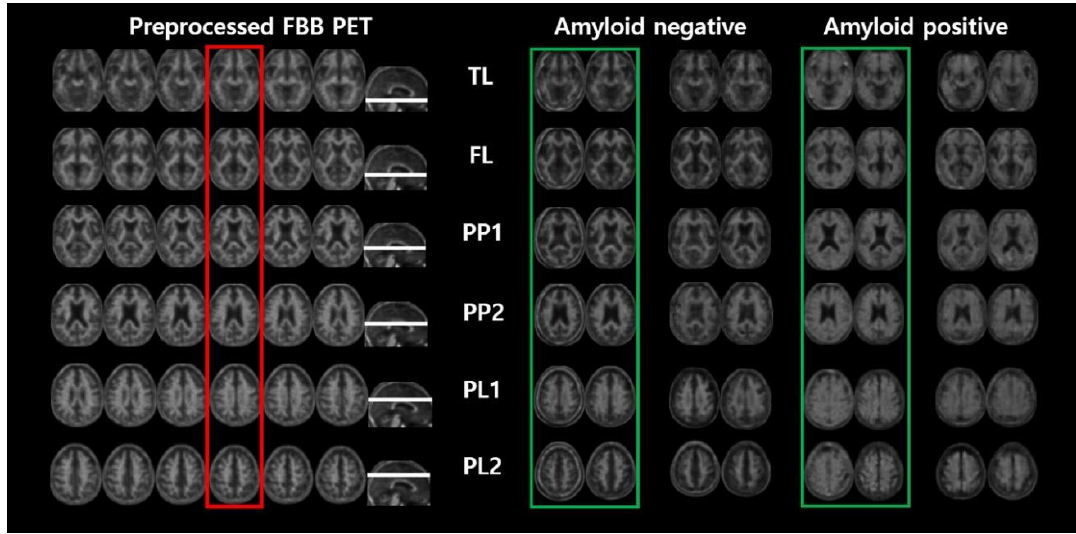
Figure 4. Pre-processed FBB PET image and randomly picked real and generated images by the generator selected from our experiment.